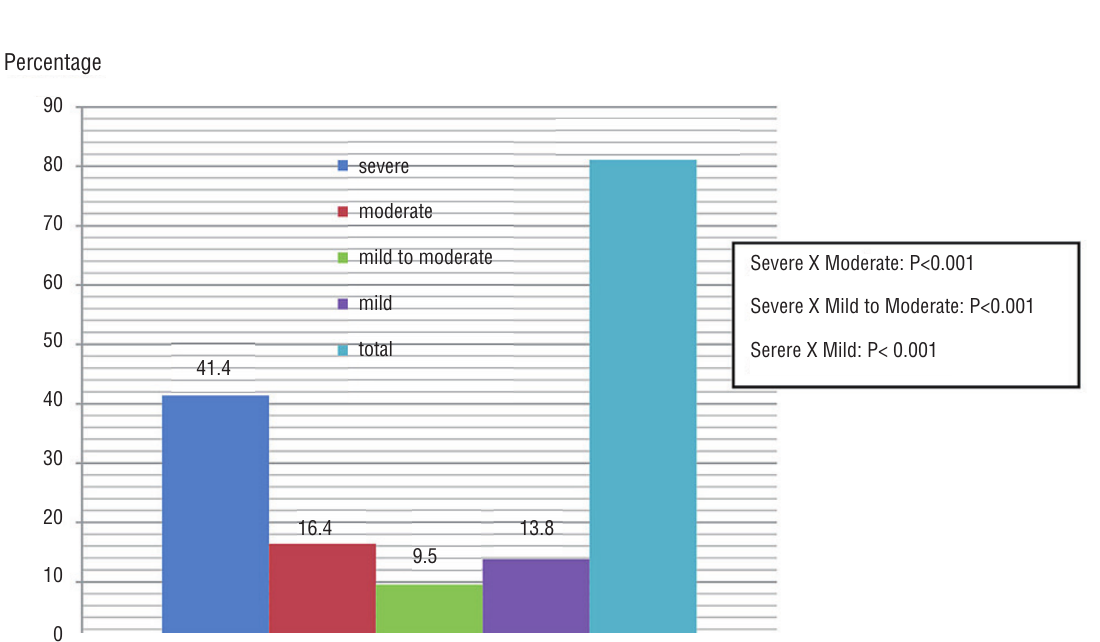
Figure 3 - Comparison of severe versus moderate, mild to moderate, and mild erectile dysfunction in patients with CKD on conservative treatment in stage Iv/v.